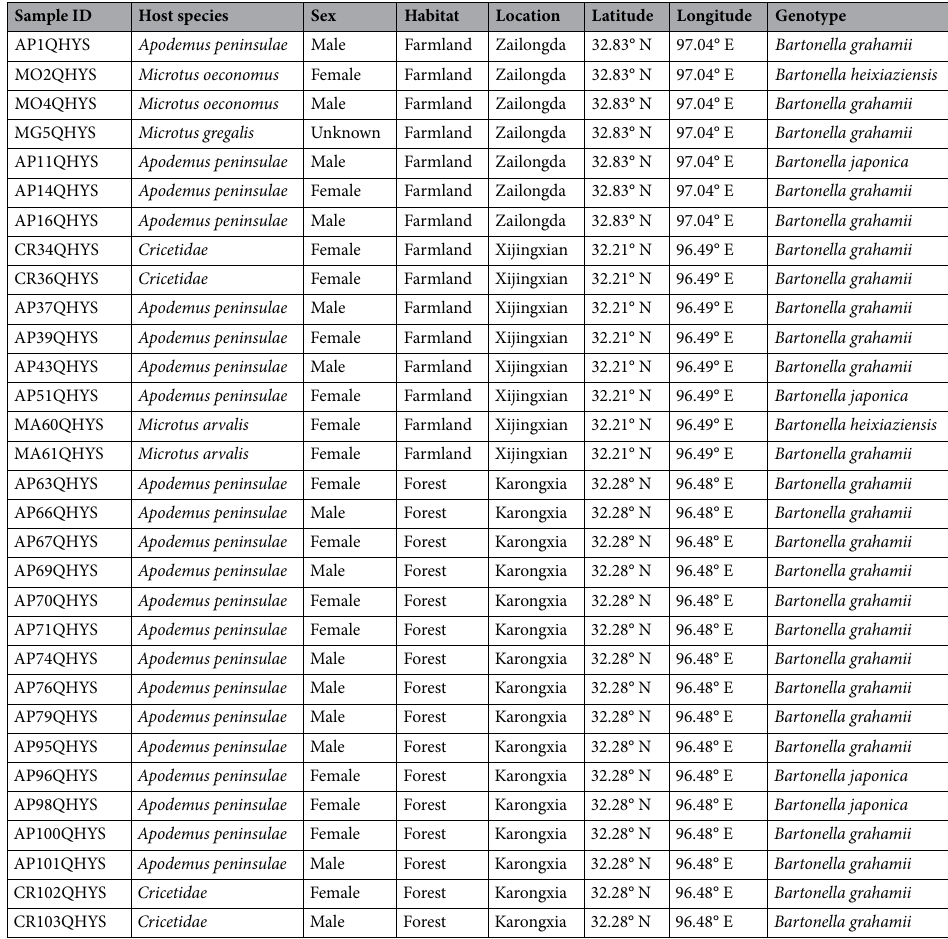
Table 3. Sampling locations of each host species with Bartonella